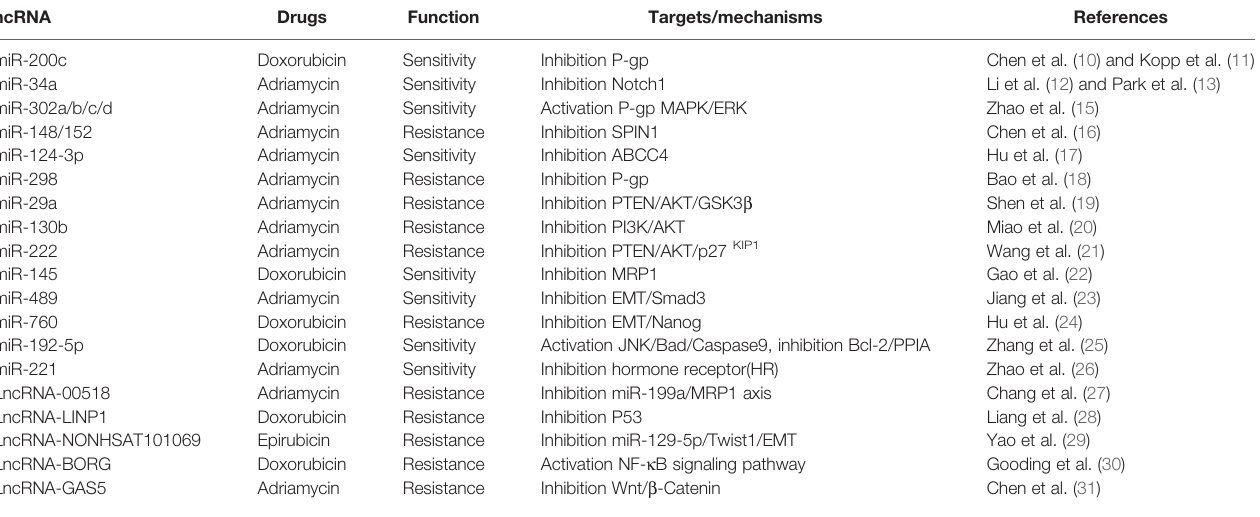
TABLE 1 | Breast cancer anthracycline chemoresistance-related